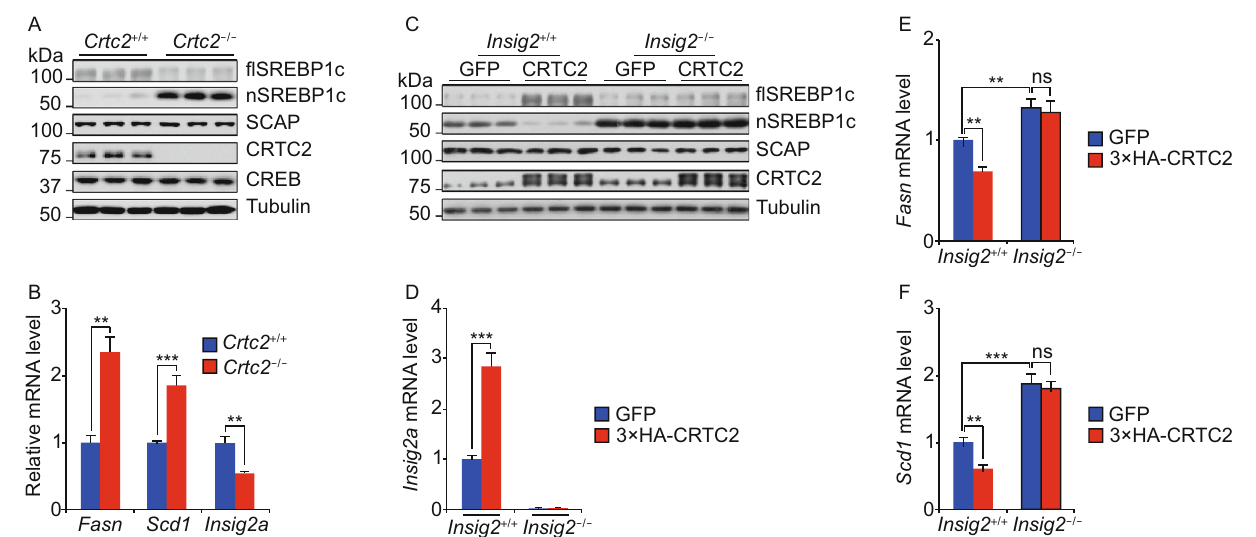
Figure 1. CRTC2 inhibits SREBP1c processing via INSIG2 during fasting . (A and B) Immunoblots showing hepatic amounts of full-length, inactive SREBP1c ( fl SREBP1c) and cleaved, active SREBP1c (nSREBP1c) in liver extracts (A) and qPCR results showing expression of lipogenic genes ( Fasn , Scd1 and Insig2a ) (B) in 12 h fasted Crtc2 +/+ and Crtc2 − / − mice. (C – F) Effect of 3×HA- CRTC2 overexpression on SREBP1c maturation (C), Insig2a expression (D), Fasn expression (E) and Scd1 expression (F) in 12 h fasted Insig2 +/+ and Insig2 − / − mice. ns, no signi fi cant statistical difference. Data are shown as mean ± s.e.m. **P < 0.01, ***P < 0.001, n =